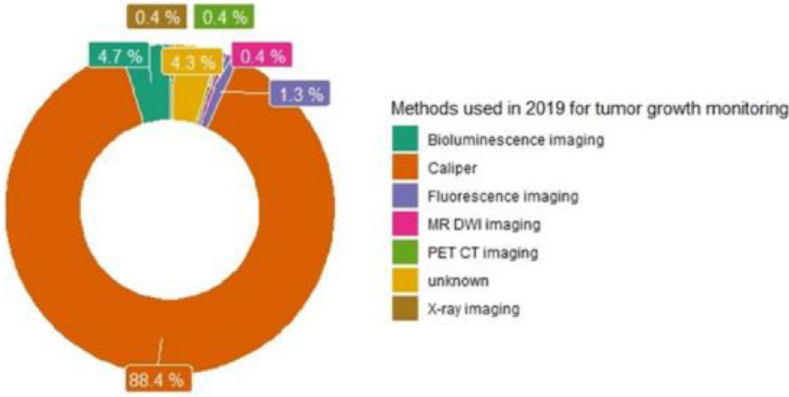
Fig 1. Representation of all techniques used in 2019 for tumor growth monitoring on human breast cancer xenografts bearing mice (n = 233). The bibliographic search was conducted in the PubMed database from January 1 st , 2019 to December 31 st , 2019 , using the followings terms in Text Word : X enograft , breast cancer , tumor growth AND mice . � MR DWI = Diffusion-weighted magnetic resonance; PET CT = positron emission tomography computing tomography; Unknown = information not